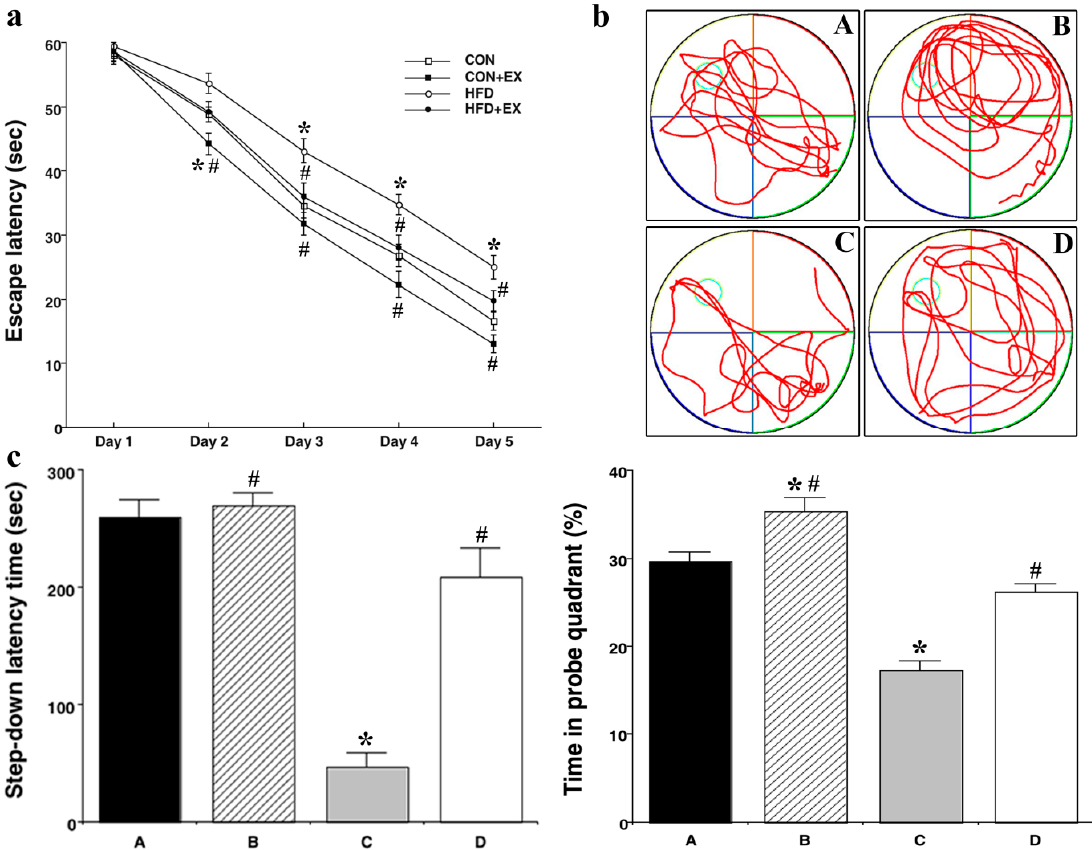
Figure 2. Effect of treadmill exercise on learning and memory using the Morris water maze and long- term memory using the step-down. Spatial learning ( a ) and working memory tracking ( b ) in the Morris water maze and long-term memory ( c ) in the step-down avoidance test. Control group A , control and exercise group B , high-fat diet group C , and high-fat diet and exercise group D . Data are expressed as the mean ± S.E.M. * Represents p < 0.05 as compared with the control (CON) group. # Represents p < 0.05 as compared with the high-fat diet (HFD) group.